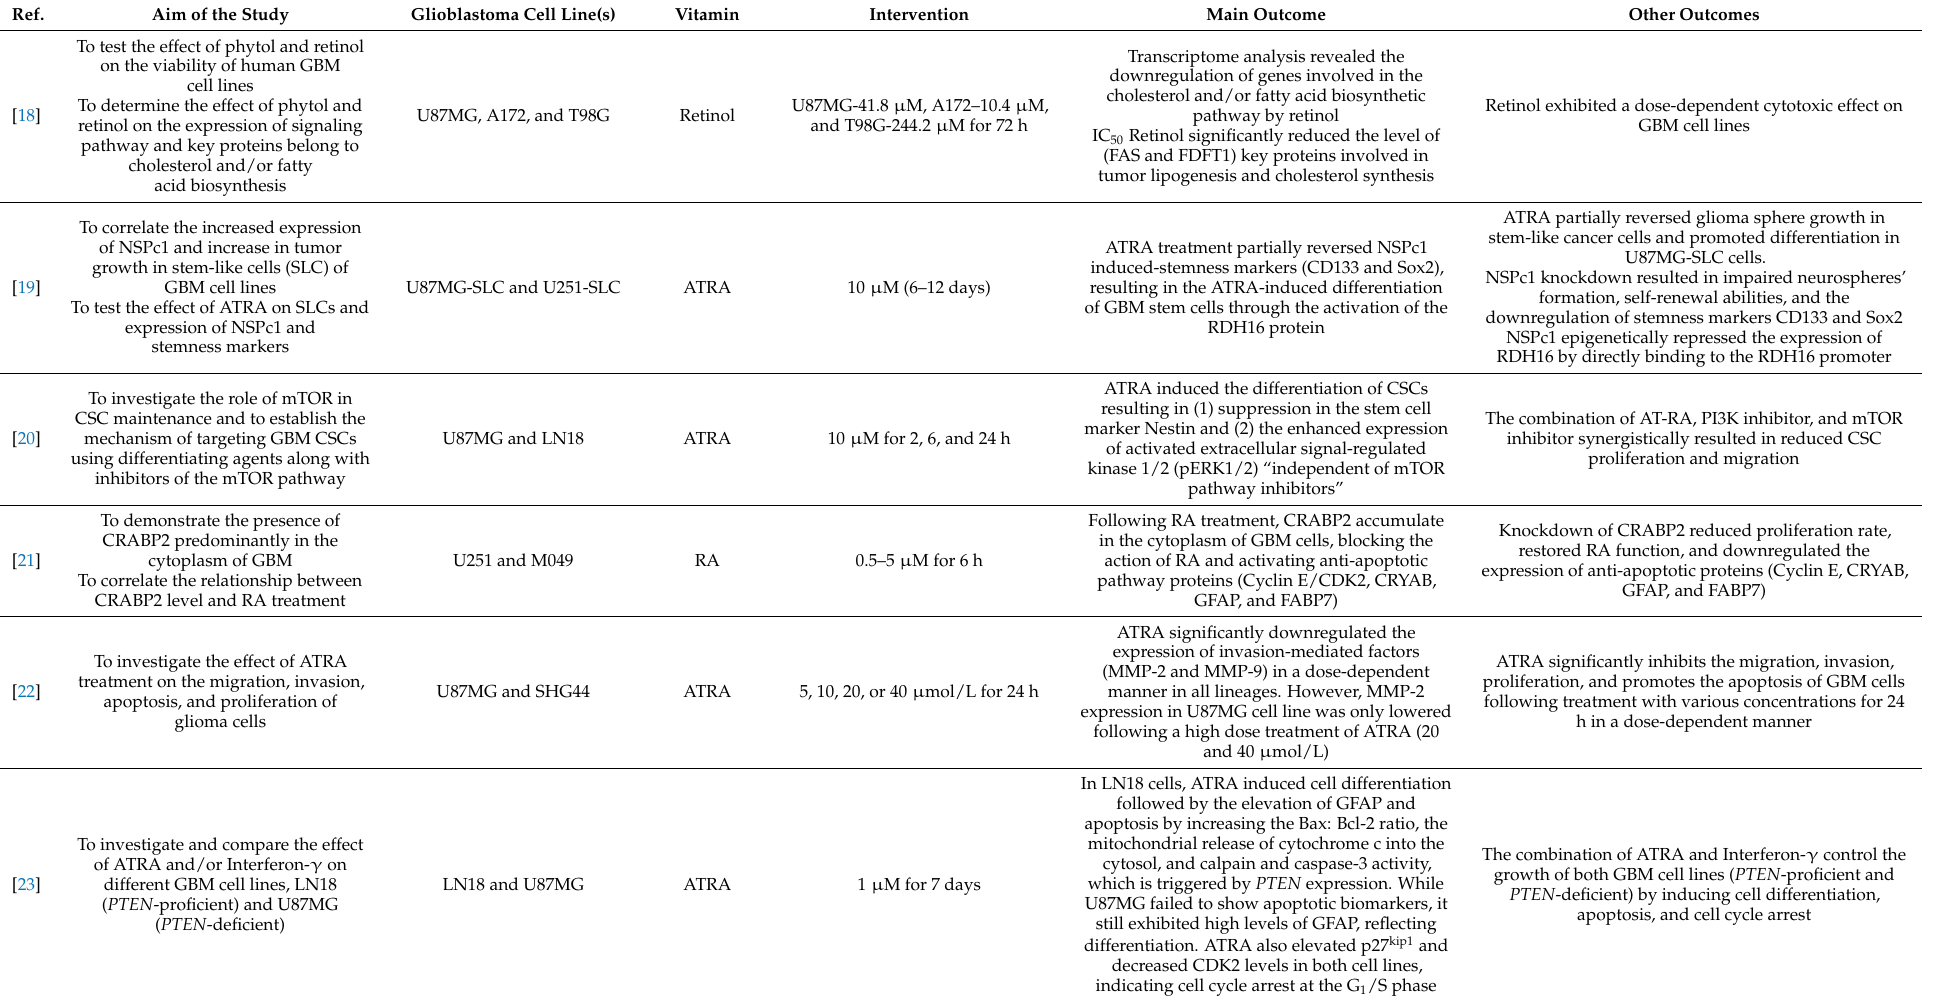
Table 1. Summary of outcomes induced by the lipid-soluble vitamins on various human glioblastoma cell